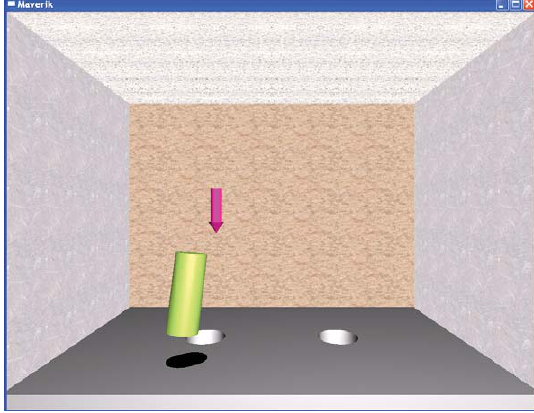
Fig. 1. Visual (on screen) representation of the peg-in-hole task.